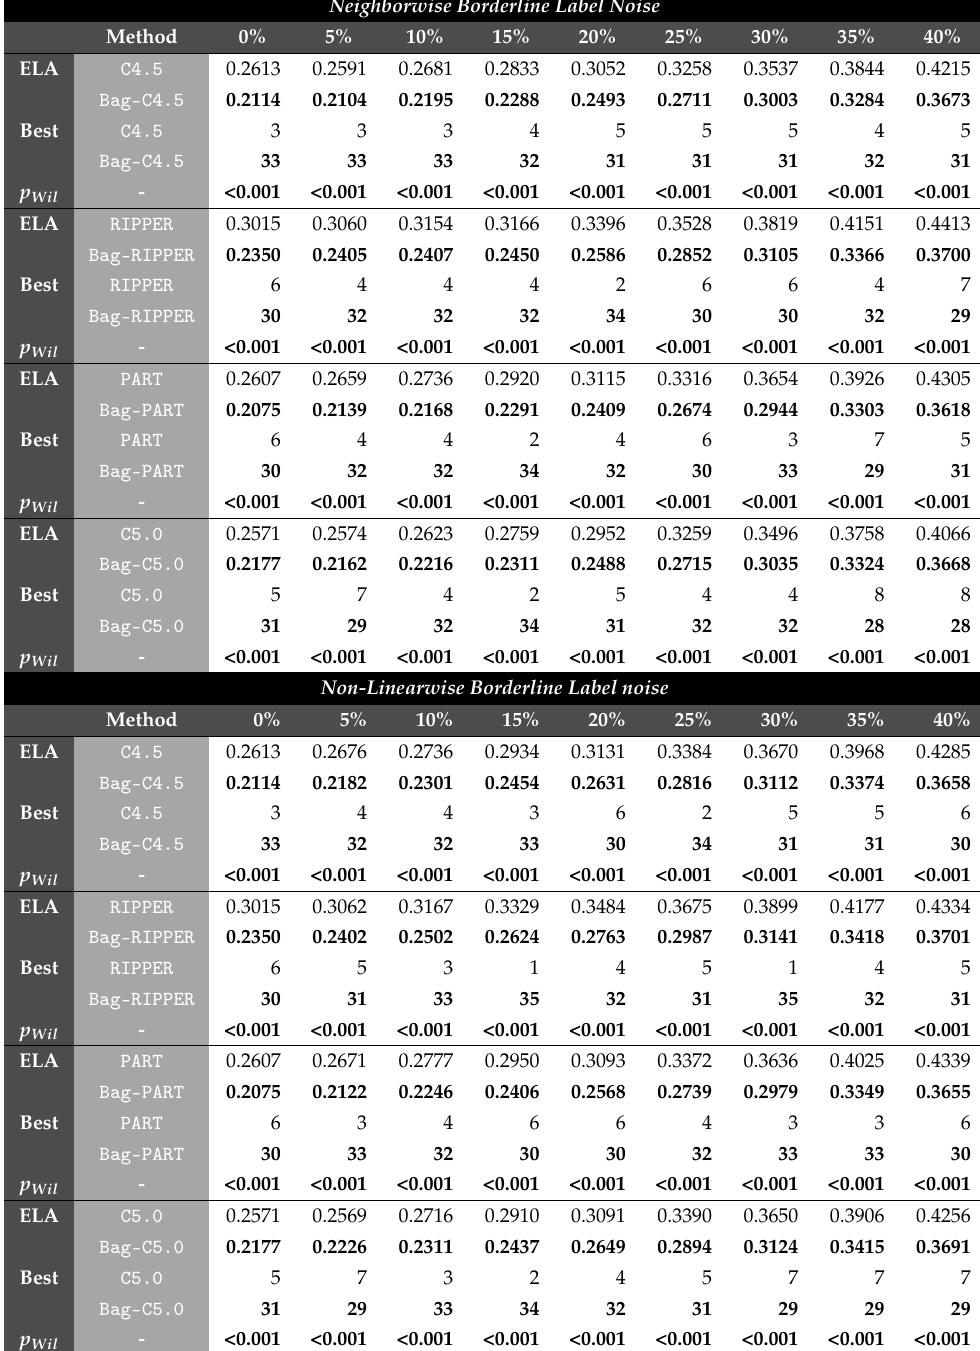
Table 3. Robustness results of baseline and bagging classifiers with borderline label